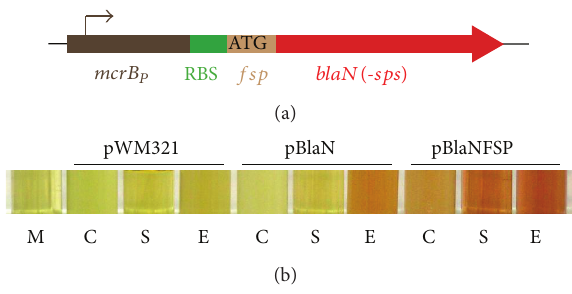
Figure 1: Synthesis of 𝛽 -lactamase in M. acetivorans . (a) scheme of blaN ( bla gene encoding 𝛽 -lactamase and lacking the sequence for signal peptide) fusions inserted into the host chromosome; fsp : sequence encoding putative methanoarchaeal flagellin signal pep- : methanoarchaeal mcrB promoter; RBS: ribosome bind- tide; mcrB P ing sequence; sps : signal peptide encoding sequence. (b) anaerobic cleavage of nitrocefin in cultures (C), culture supernatants (S), and cell lysates (E) of M. acetivorans strains carrying bla without (pBlaN) or with (pBlaNFSP) a putative archaeal signal peptide sequence on the chromosome, or the E. coli ampicillin resistance cassette on a self-replicating plasmid (pWM321), respectively; shown are sections of the culture tubes after 20 min of incubation at room temperature in the presence of 20 𝜇 M nitrocefin.